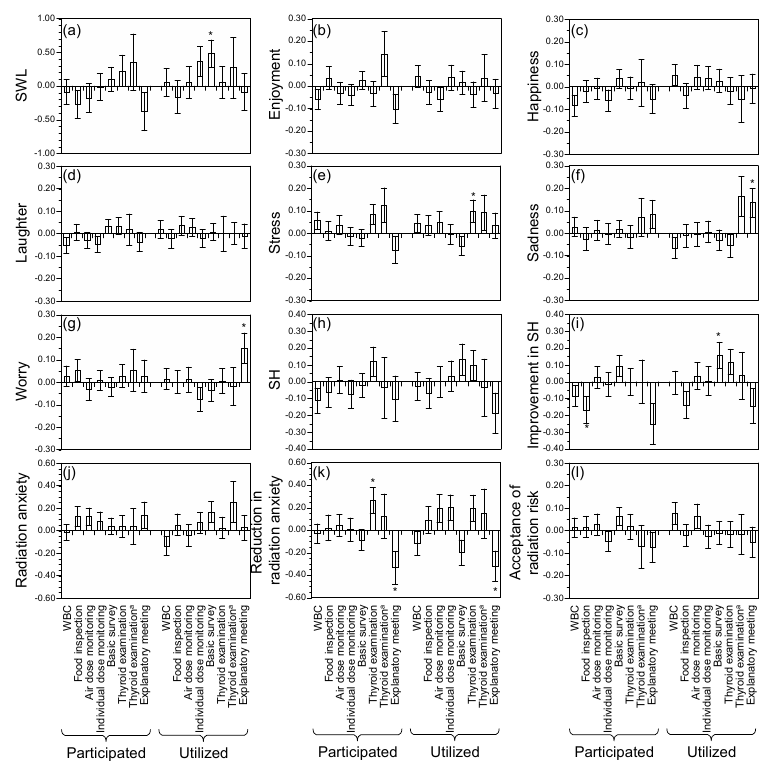
Figure 1. Differences in outcomes according to participation in (or utilization of) radiological countermeasures. Data were adjusted using propensity score matching. The values represent differences in outcomes between pairs of “participated” and “did not participate” or pairs of “utilized” and “did not utilize”. Wilcoxon’s matched ‐ pairs signed ‐ rank test was used to test differences in outcomes between pairs. ( a ) SWL; ( b ) Enjoyment; ( c ) Happiness; ( d ) Laughter; ( e ) Stress; ( f ) Sadness; ( g ) Worry; ( h ) SH; ( i ) Improvement in SH; ( j ) Radiation anxiety; ( k ) Reduction in radiation anxiety; ( l ) Acceptance of radiation risk. Participated: respondents and/or their family participated. WBC: whole body counter; SWL: satisfaction with life; SH: self ‐ rated health. Error bar represents standard error. * p < 0.05. a : Respondents or their family members are subjects of examination.